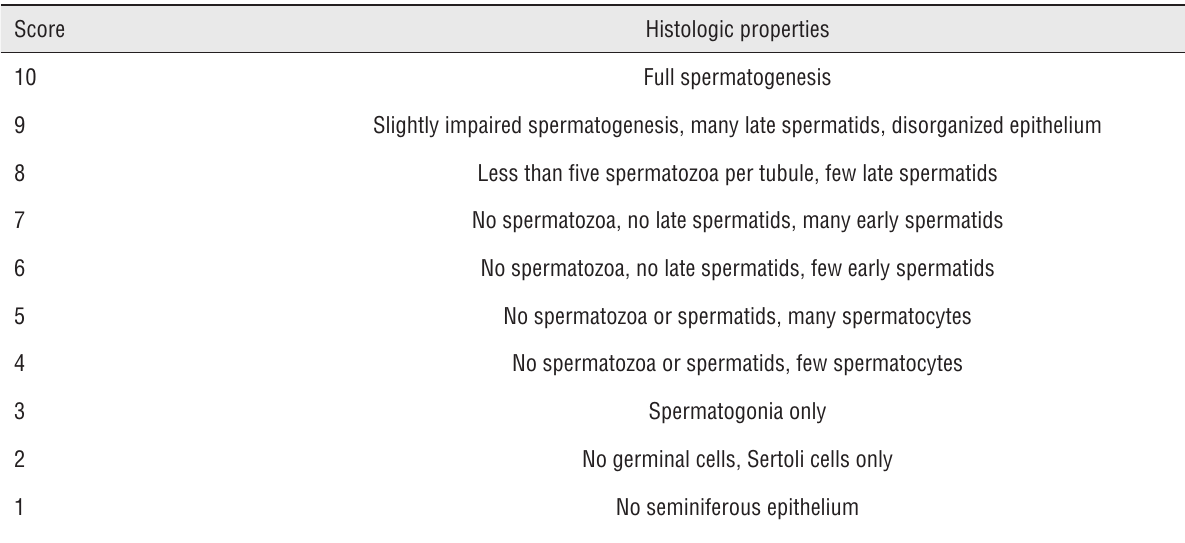
Table 1 - Histological criteria and the modified Johnsen score system for assessment of spermatogenesis.